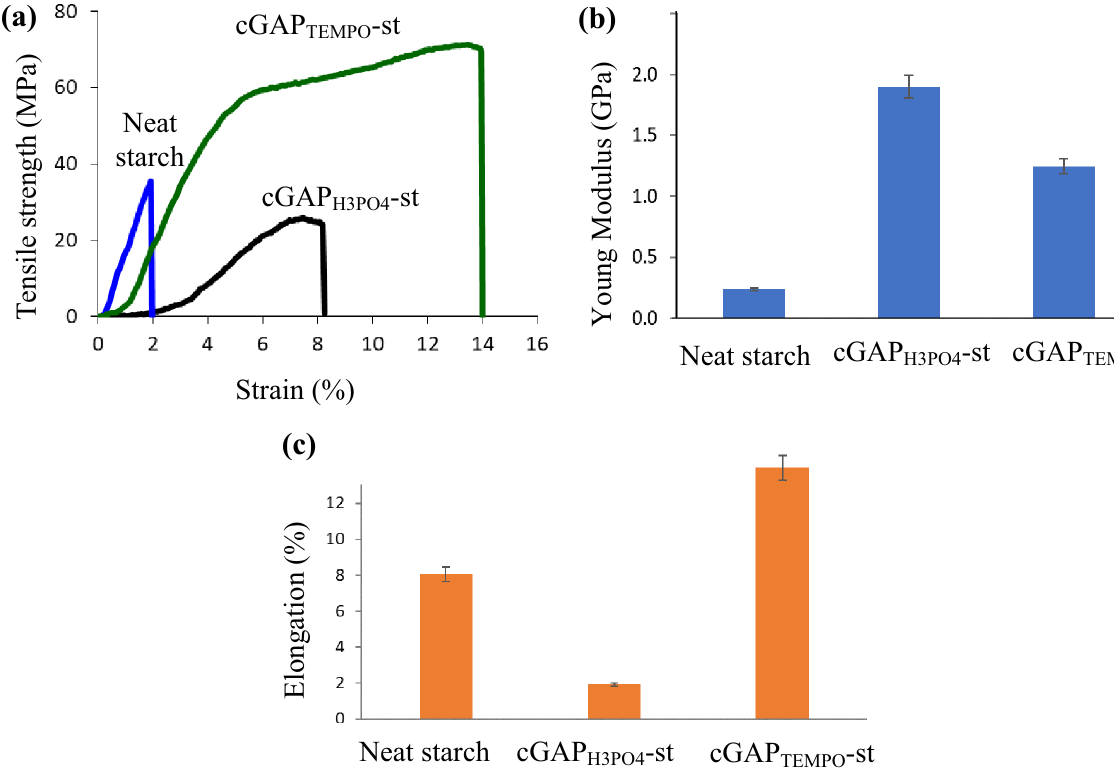
Fig. 4 Mechanical properties of starch–cellulose paper waste: a representative stress–strain curves; b Young Modulus; and c elongation at break for starch cellulose paper waste treated with H 3 PO 4 and